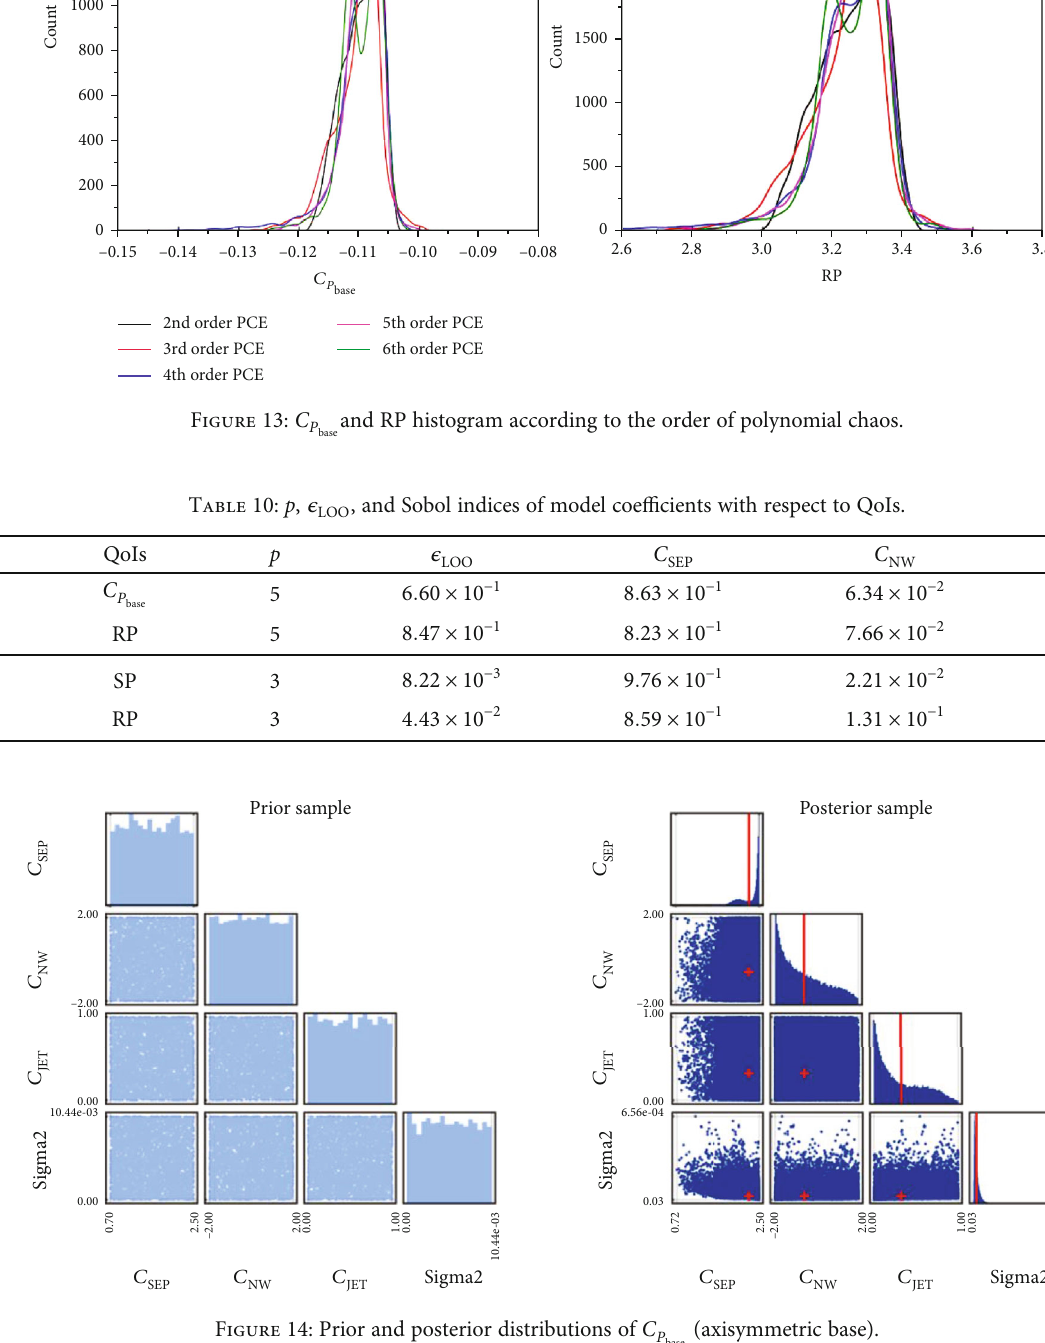
(axisymmetric P base